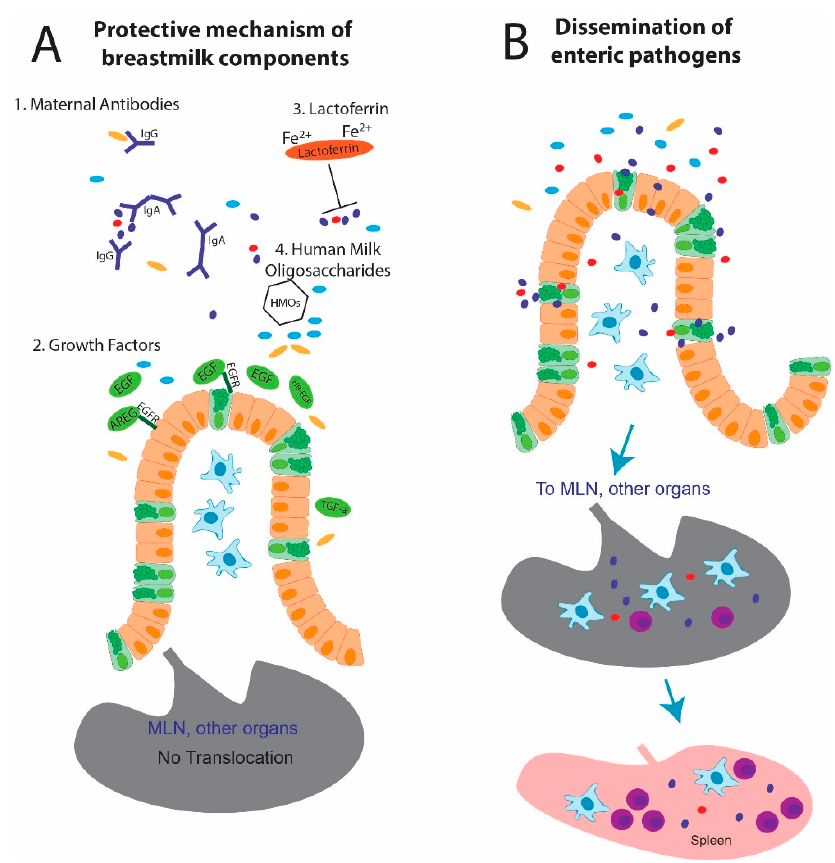
Figure 1. Maternal protection from enteric pathogens. ( A ) Components in breastmilk can limit enteric pathogen dissemination. (1) Maternal antibodies (IgG, IgA) can bind bacteria and directly inhibit pathogen adherence and invasion [62]. (2) Growth factors [epidermal growth factor (EGF), amphiregulin (AREG), heparin-binding epidermal growth factor-like factor (HB-EGF), and tumor-growth factor-alpha (TGF- α )] bind the epidermal growth factor receptor (EGFR) on epithelial cells to promote barrier function by cell proliferation and growth [63], and by limiting translocation via goblet cells [64]. (3) Lactoferrin sequesters iron which limits pathogen growth [65]. (4) Human milk oligosaccharides (HMOs) promote the development of the intestinal microbiota [66], which can offer colonization resistance to enteric pathogens [30]. ( B ) In the absence of these factors, pathogens can colonize the intestine lumen, cross the epithelium potentially through goblet cells [64], and disseminate to organs through the system, including the mesenteric lymph node (MLN) and spleen, resulting in late-onset sepsis (LOS).